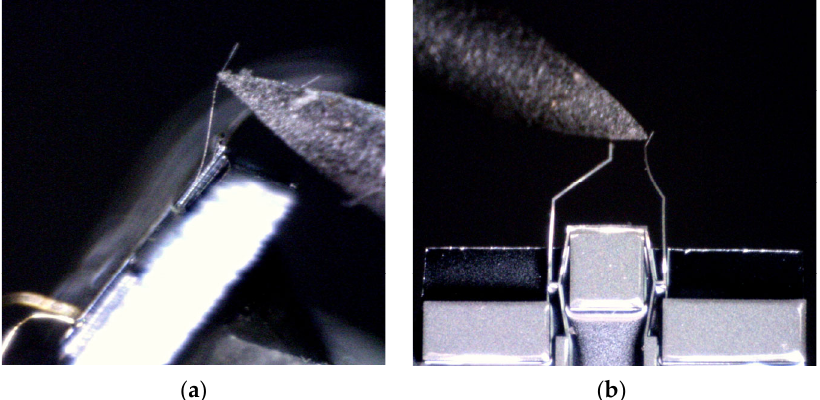
Figure 15. Micro-tweezer tests at forced deformation: ( a ) Bending up of a micro-tweezer free arm; ( b ) Lateral bending of a micro-tweezer free arm.